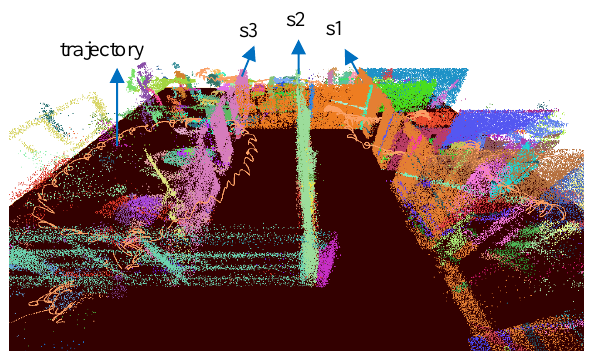
Figure 1. The trajectory (the zigzag orange line) and segments; s1, s2 and s3 are real surface, glass surface and reflected surface respectively. The data is acquired by ZEB1.